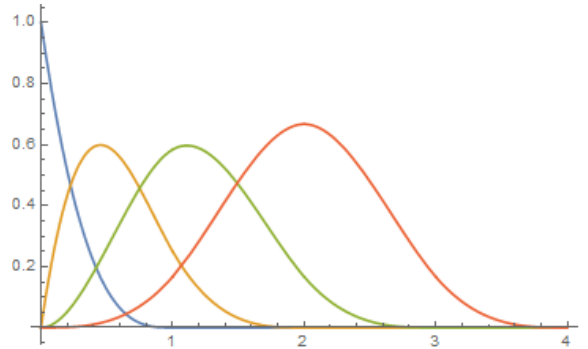
Figure 4. The left-edge functions N 03 (blue), N 13 (orange), N 23 (green), and the cubic cardinal B-spline B 3